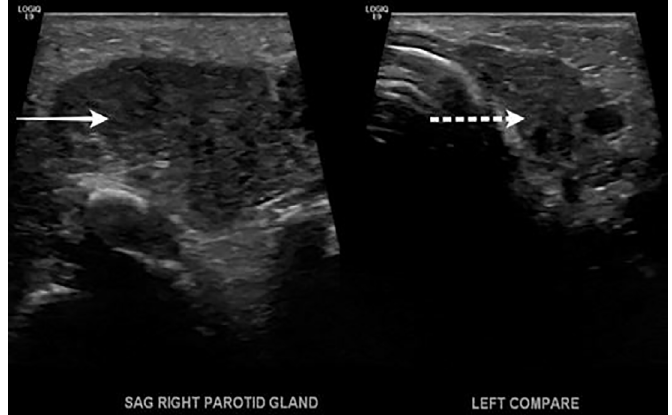
Image 3. Parotid point-of-care ultrasound with Doppler showing increased vascularity (multiple white arrows) around the swollen right parotid gland, confirming